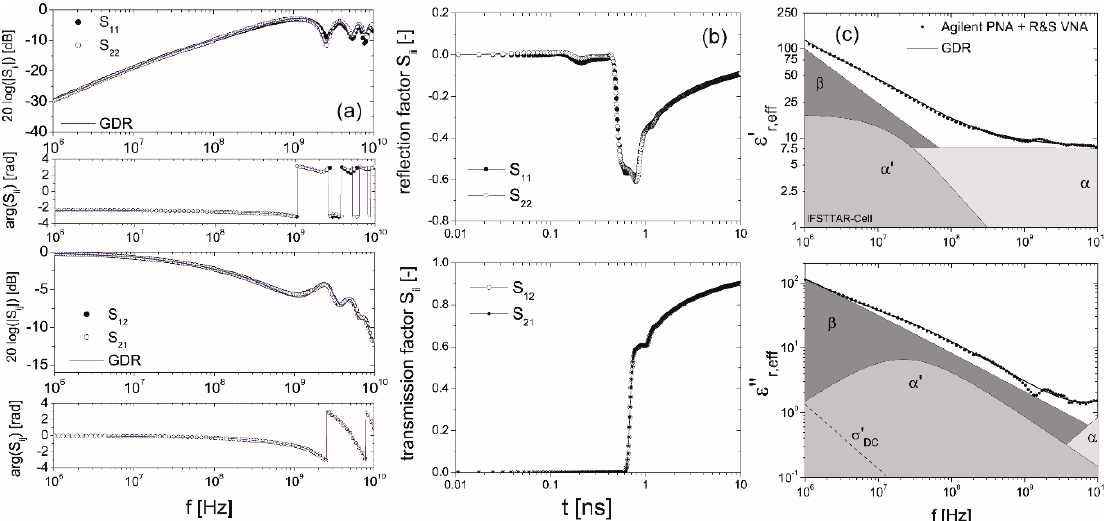
Figure 3. ( a ) S-Parameter S ij ; ( b ) TDR waveform; and ( c ) complex effective relative permittivity r,eff * ε ˚ as a function of frequency f of a sample at intermediate water saturation ( θ = 0.066 m 3 /m 3 , n = 0.14 and S W = 0.46) as well as the results of the parameterization with a global optimization procedure.